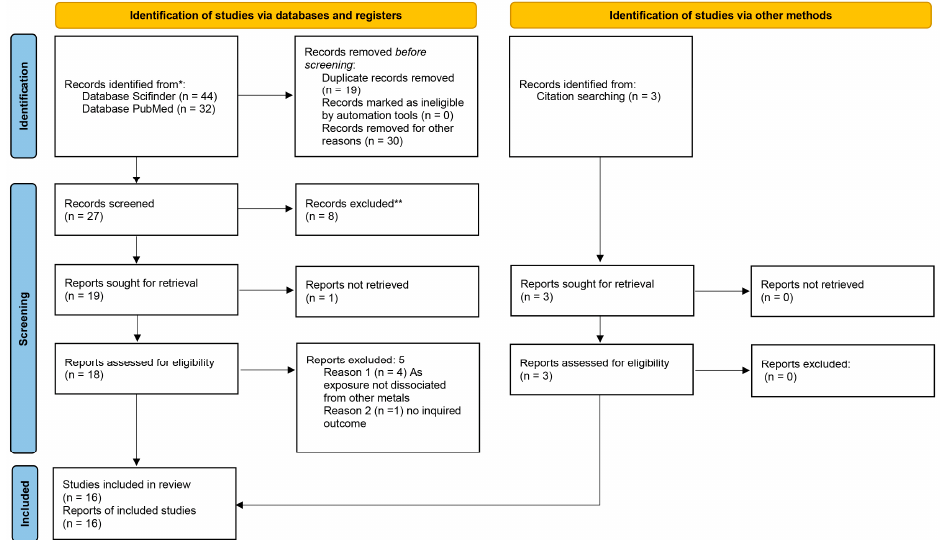
Figure 1. Prisma flow chart of the included studies [25]. * The bibliographic search was limited to those papers published from 2010 to 2022. ** The exclusion was done through discussion between the reviewers.